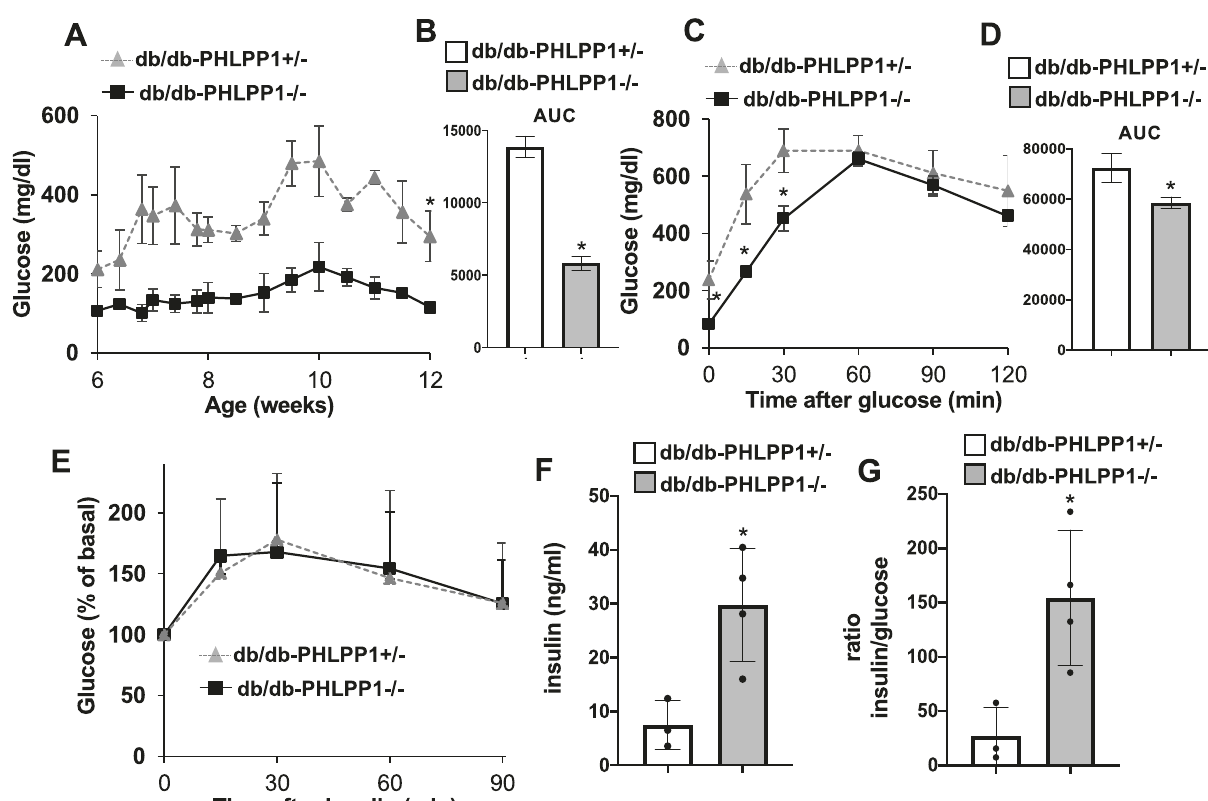
Fig. 1 PHLPP1 depletion improves glycemia in the obese db/db mouse model of type 2 diabetes. Male db/db-PHLPP1 − / − ( n = 4) and db/ db-PHLPP1 + / − ( n = 3) were monitored for A , B random fed blood glucose with respective area-under-the-curve (AUC) analysis from the age of 6 weeks throughout the 6-week experiment. C , D Intraperitoneal glucose tolerance test (ipGTT) with respective AUC analysis, E Intraperitoneal insulin tolerance test (ipITT) with basal glucose values normalized to 100%, F serum insulin, and G the ratio of serum insulin and blood glucose calculated at fed state at the end of the study in 12-weeks-old mice. Data show means ± SEM. * p < 0.05 db/db-PHLPP1 − / − compared to db/db-PHLPP1 + / − ; all by Student ’ s t